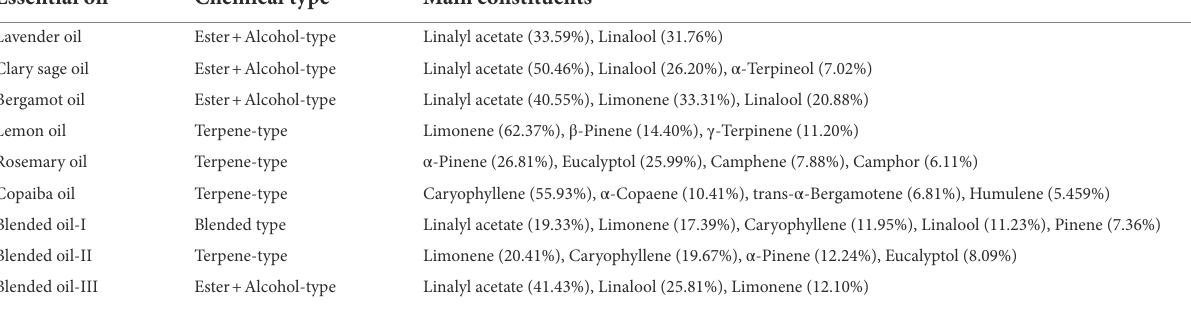
TABLE 2 The essential oil used in the study and their main